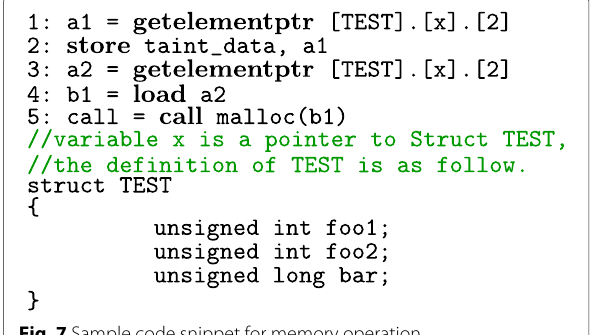
Fig. 7 Sample code snippet for memory